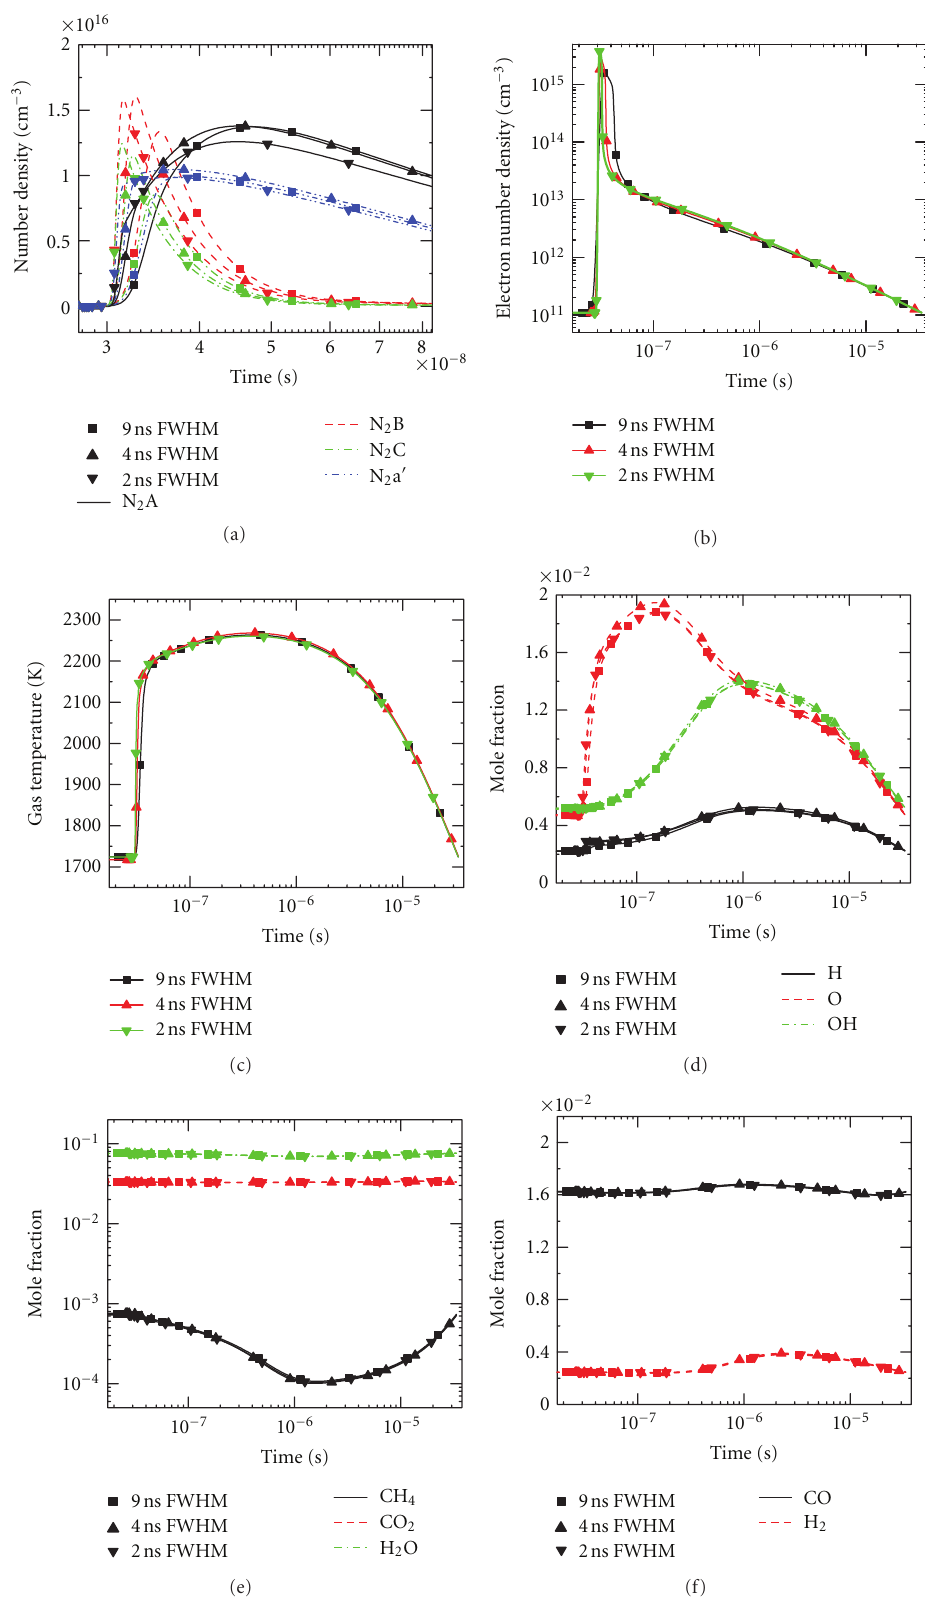
Figure 5: Kinetic evolution of (a) excited electronic states of N 2 (A, B, C, a (cid:2) ), (b) electron, (c) gas temperature, (d) radicals (O, H, and OH), (e) combustion major species (CH 4 , CO 2 , and H 2 O), and (f) minor species (H 2 and CO) within the discharge region during a single period when the repetition rate is 30kHz and pulse widths are 9ns, 4ns, and 2